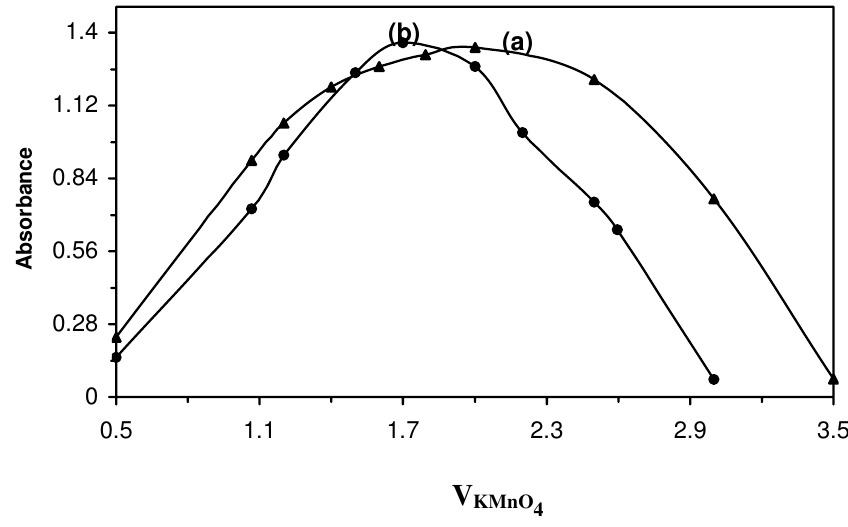
Fig. 2 Effect of volume of 5.0 × 10 − 4 M KMnO product: (a) 9.0 µ g ml − 1 gentamicin with MB and (b) 4.0 µ g ml − 1 vancomycin with